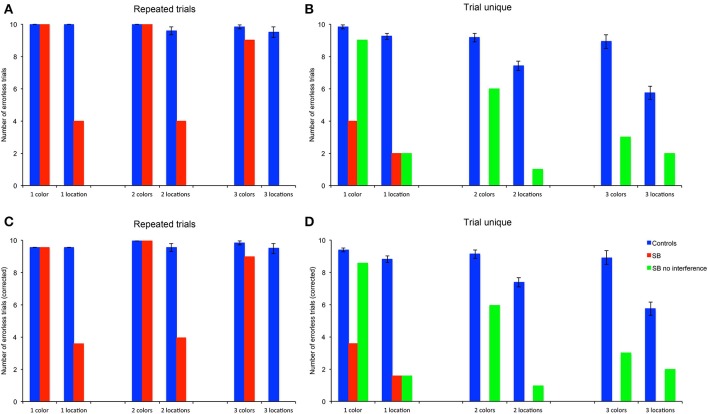
Number of errorless trials (NET): number of trials in which subjects made no errors. (A,B) Number of trials. (C,D) Number of trials corrected for the probability to find all goal locations by chance (4.3478% with one location (1/23), 0.3953% with 2 locations (2/23 * 1/22), 0.0565% with 3 locations (3/23 * 2/22 * 1/21). P9's performance was impaired as compared to controls in all conditions, except for the color, repeated-trials condition with one, two and three goals, and in the trial-unique color condition with one goal and no interference.